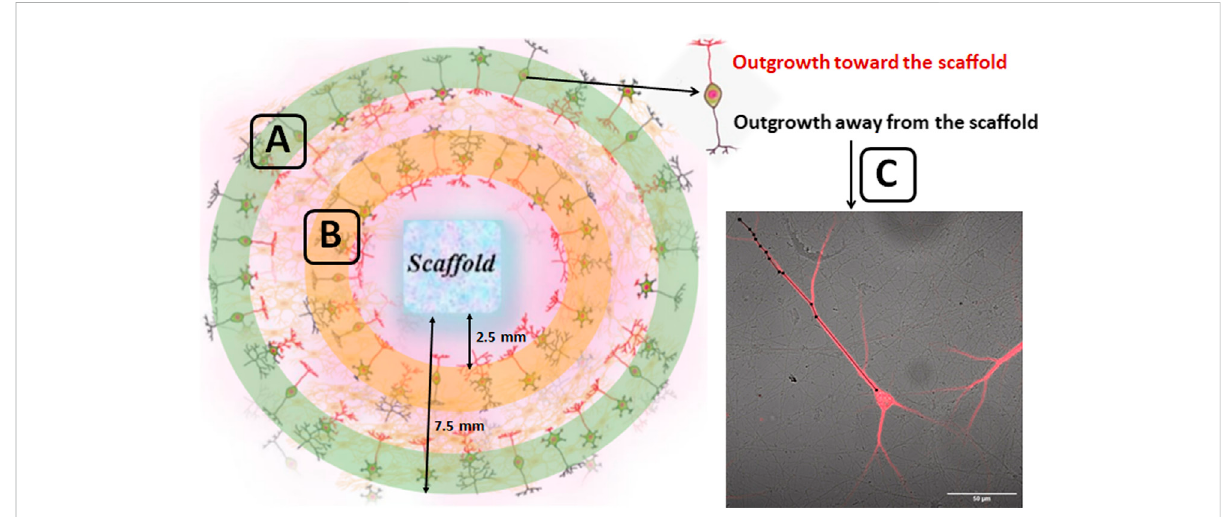
FIGURE 1 Schematic representation of counting regions of the outgrowth dynamics of neuronal processes in primary hippocampal culture. The cell suspension obtained from embryonic hippocampi was placed around thescaffold. The approximate distance of theinner and outer edge ofthe ring relative to the scaffold was 2.5 and 7.5 mm respectively. The outgrowth dynamics of neuronal processes was assessed in the 10 fi elds of view for distant (green zone) (A) as well as for adjustment areas (orange zone) (B) of cultures relative to the scaffold. The neuronal processes growing towardthescaffold(markedinred)andawayfromthescaffold(markedinblack)wereanalyzed.Thelengthofneuronalprocesseswascountedfrom the neuron ’ s body to the terminus of the neurite (C) using ImageJ